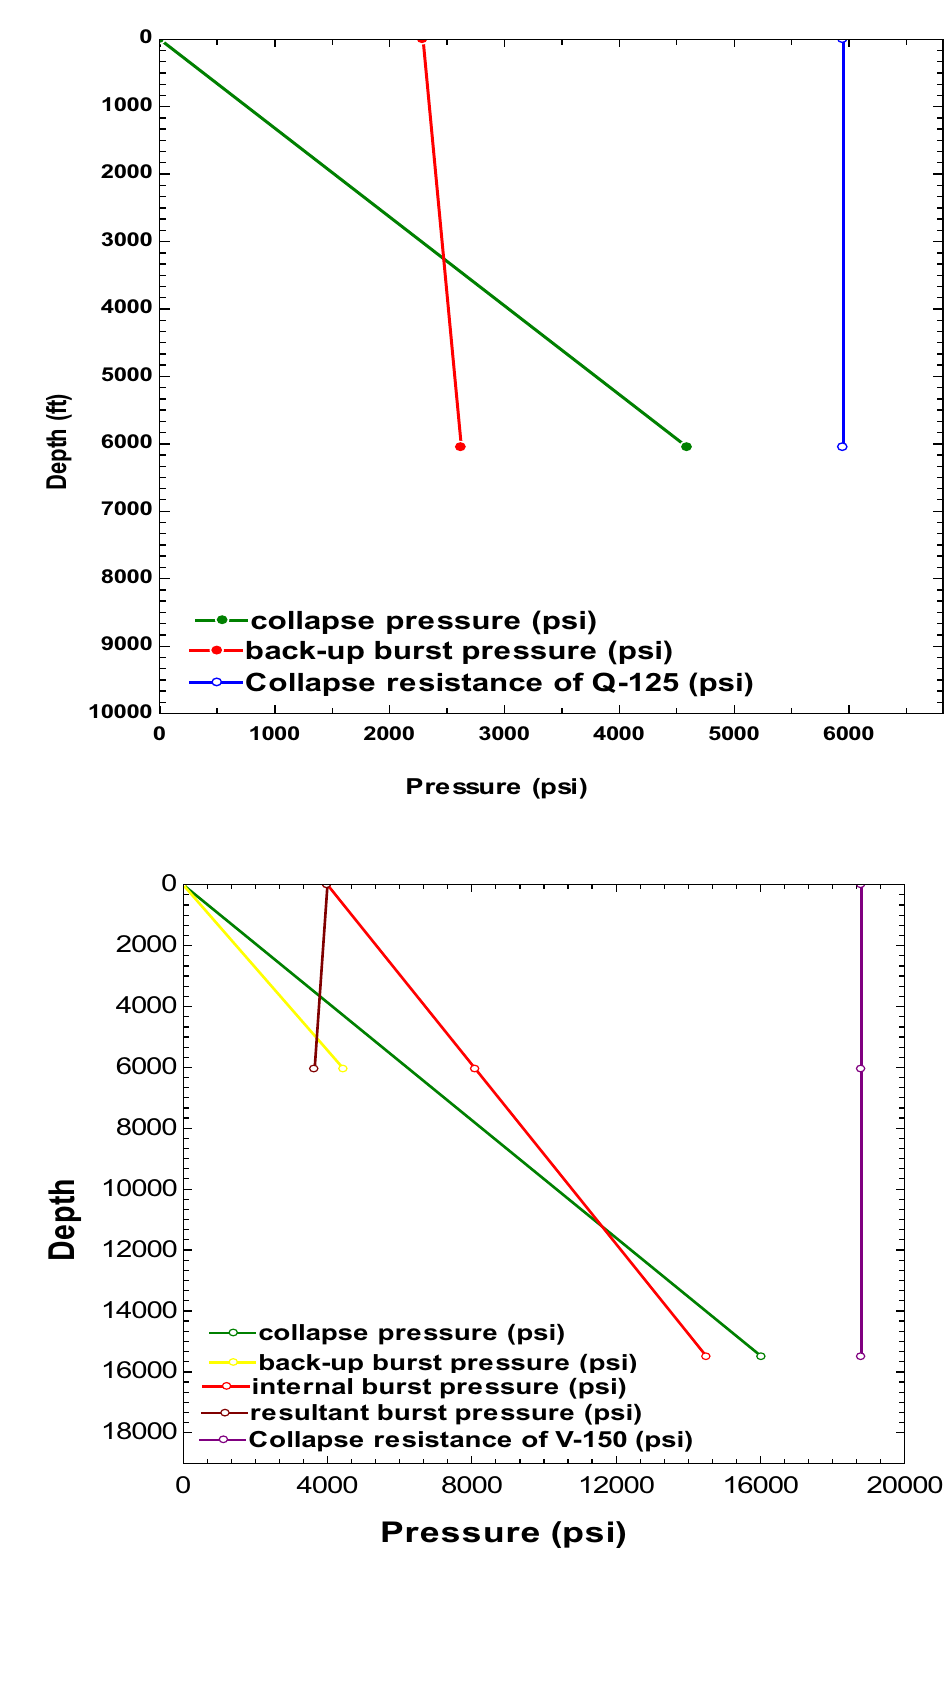
Fig. 12 Surface casing selection